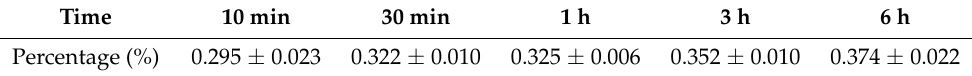
Table 1. The mass percentage of cumulative SF released from the SF/CMCS hydrogel over time.